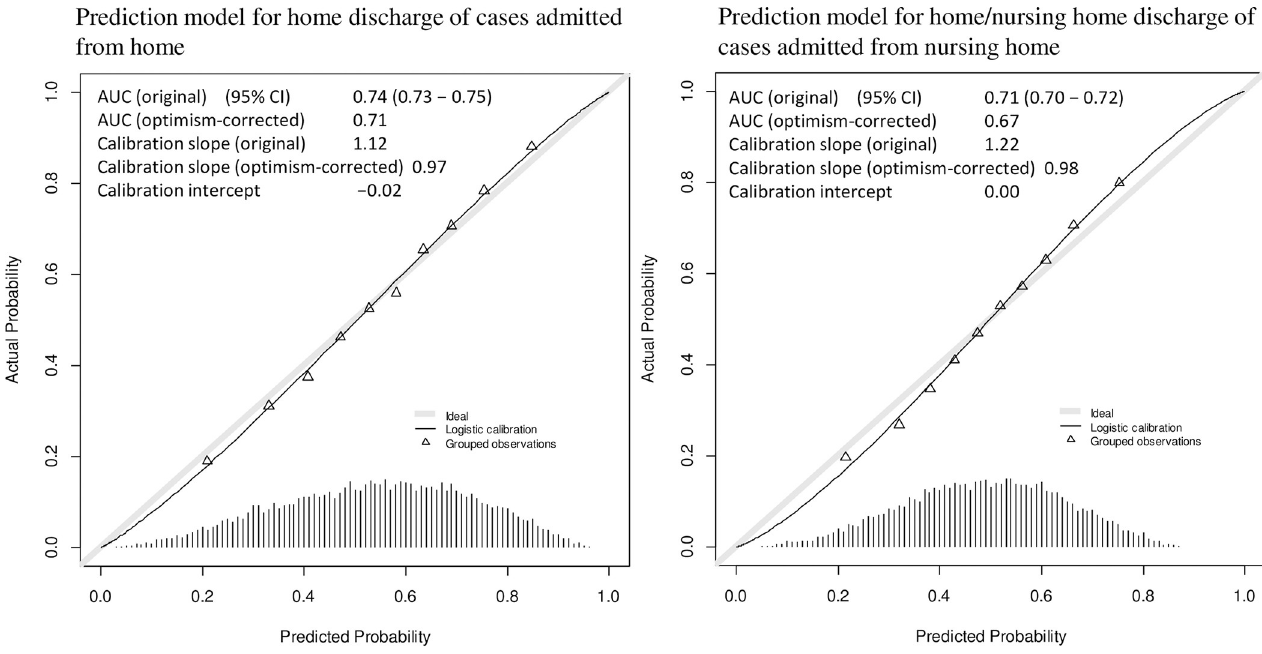
Fig 2. Results of internal validation with calibration plots of the two models. AUC, area under curve; 95% CI, confidence interval.